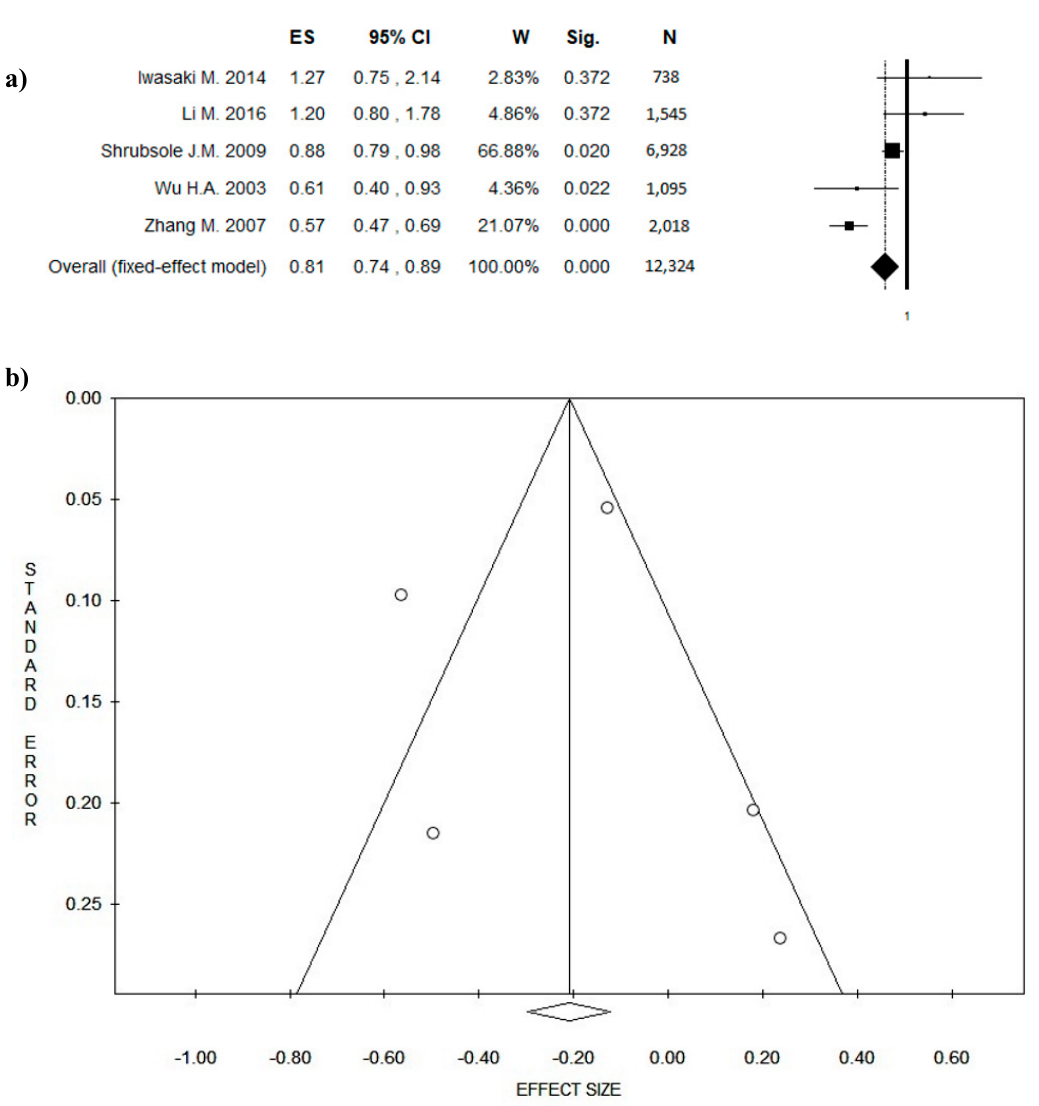
Figure 3. Forest plot ( a ) of the meta-analysis comparing green tea consumption in breast cancer (BC) prevention (case-control studies). Funnel plot ( b ). Abbreviations: ES = effect size; CI = confidence interval; W = weight; Sig = significance; N = number.